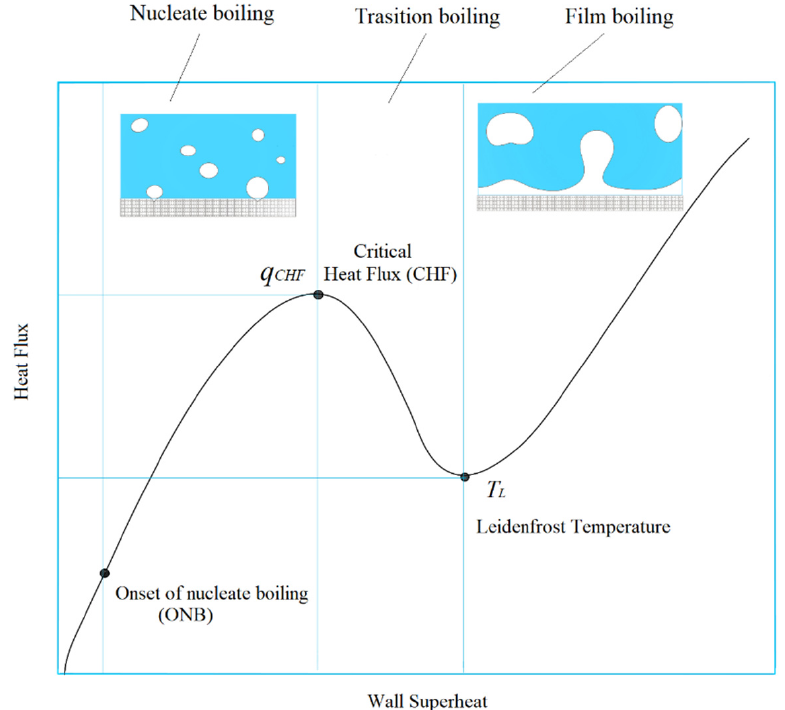
Figure 1. Nukiyama curve of pool boiling heat transfer.